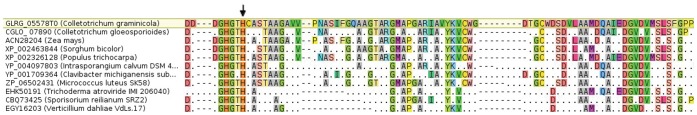
Representative portion of a multiple sequence alignment of CPLSs and subtilisins from plants, bacteria and fungi.The three best BLAST hits to GLRG_05578 from each taxonomic group were used to create the alignment. Amino acid disagreements to GLRG_05578 are represented by dots. Gaps are represented with a dash symbol. The arrow over the alignment indicates the position of the conserved histidine residue of the catalytic site of subtilisins.